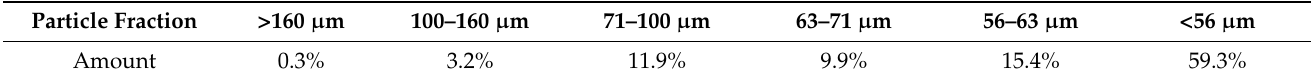
Table 3. Fine particle